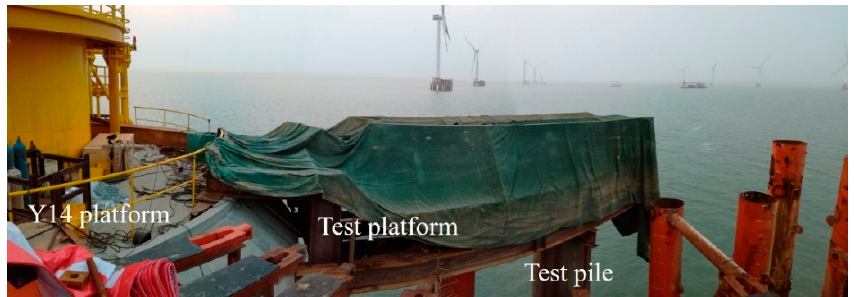
Figure 5. Entire experimental device.